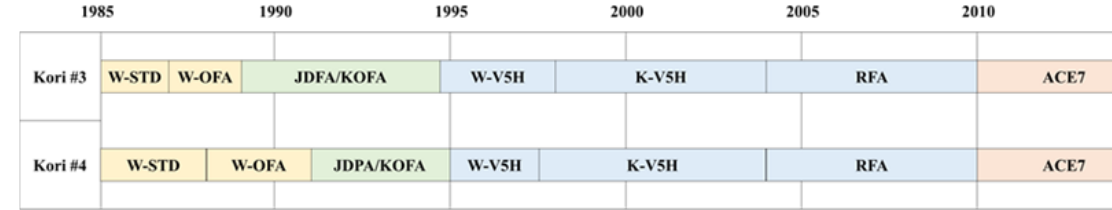
Figure 3. Types of nuclear fuels supplied for Kori units 3 and 4.